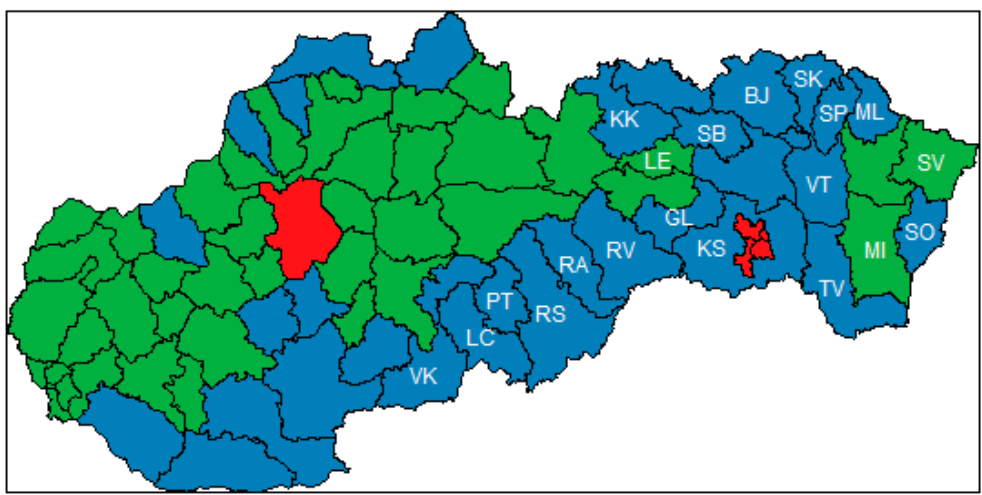
Figure 3. Cluster analysis of Slovak districts. Note: Colors represent clusters of districts, Lu č enec district (LC), Poltár district (PT), Revúca district (RA), Rimavská Sobota district (RS), Ve ľ ký Krtíš district (VK), Kežmarok district (KK), Sabinov dsitrict (SB), Svidník district (SK), Vranov nad Top ľ ou district (VT), Gelnica district (GL), Rož ň ava district (RV), Sobrance district (SO), Trebišov district (TV), Bardejov district (BJ), Medzilaborce district (ML), Košice-okolie district (KS), Levo č a district (LE), Snina district (SV), Stropkov district (SP), and Michalovce district (MI).